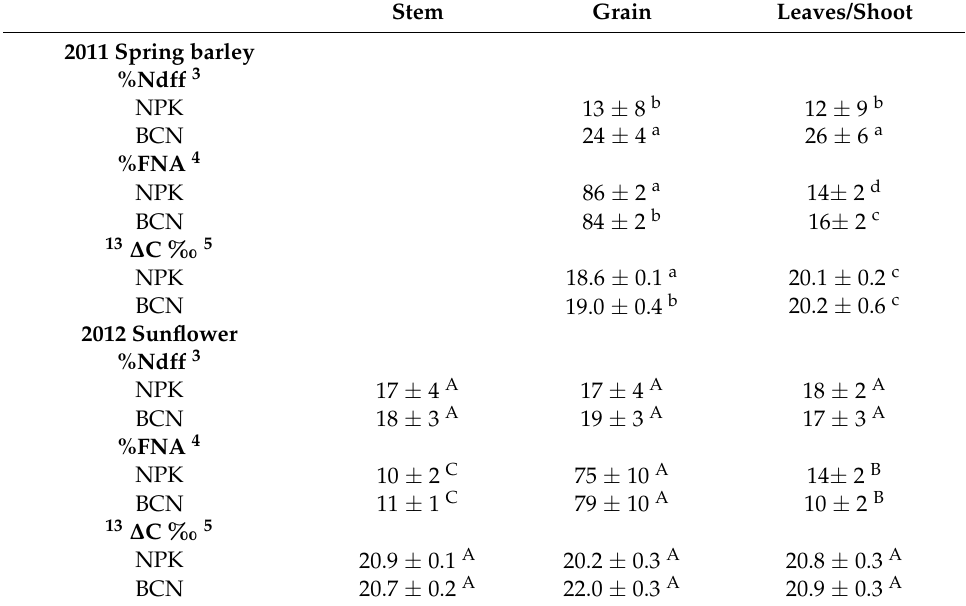
Table 2. % Nitrogen derived from top dressing fertilizer (Ndff) and % fertilizer nitrogen allocated (FNA) to the various plant parts. Carbon isotope discrimination in spring barley and sunflower following biochar soil application in 2011 (mean ± standard deviation). Different letters indicate significant differences between treatment means within single years ( p < 0.05; n = 8, using Student’s t -test). Stem Grain